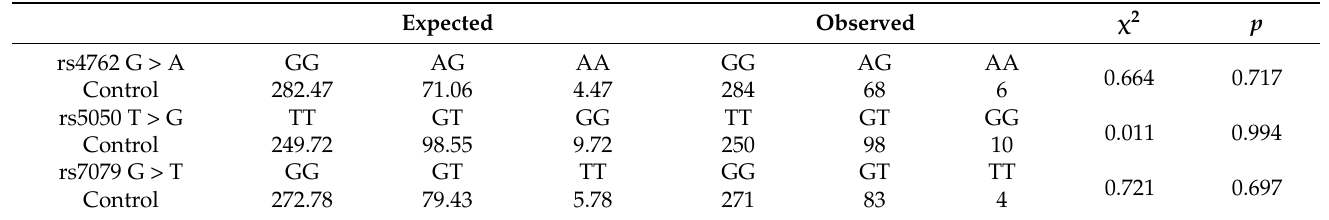
Table 3. Hardy–Weinberg equilibrium of three AGT SNPs genotype distribution frequency in the control group.